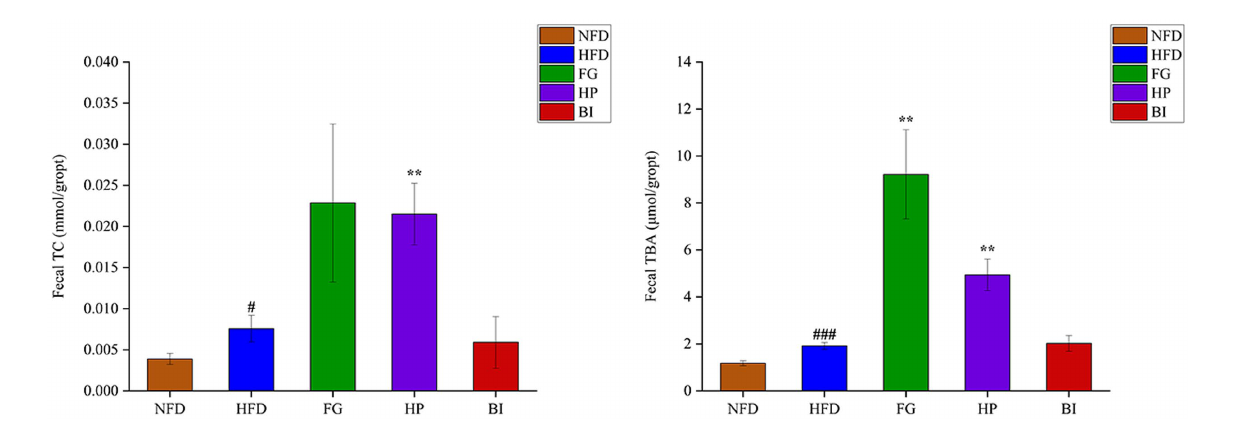
FIGURE 3 Effects of FG, HP and BI on the fecal lipid levels in HFD-fed rats. The Fecal TC and Fecal TBA levels were shown. Values are expressed as mean ± SD in each group ( n = 6). Significantly different from NFD group, # p < 0.05, ### p < 0.001. Significantly different from HFD group, ** p < 0.01.